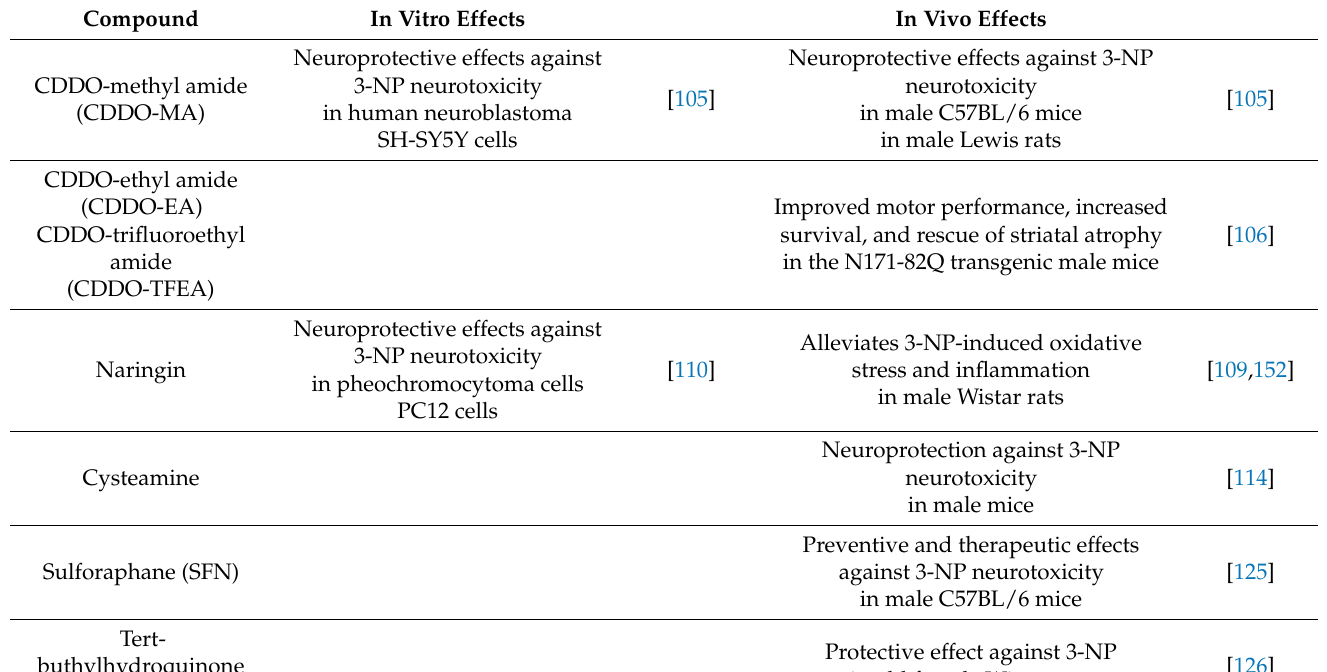
Table 1. Evidence from substance treatments supporting a role for NRF2 in HD models. In this table are reported a summary of results from substances tested in vitro and in